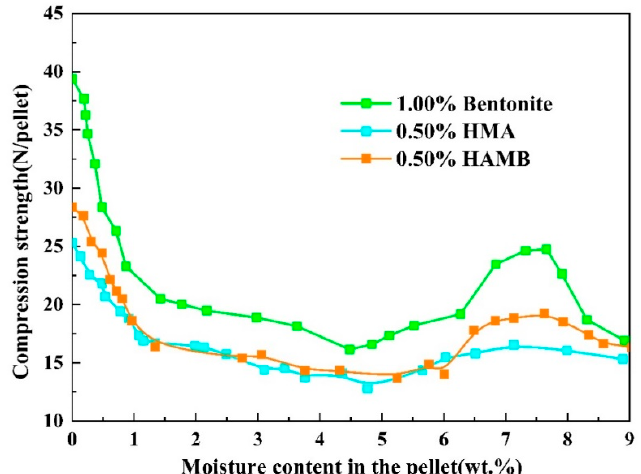
Figure 5. The relationship between moisture content in the pellet and compression strength. After the pelletizing process, the wet strength of the green pellet can reach a certain value due to the capillary force to bond mineral particles together into a mass. Then, at the beginning of the drying process, the capillary water in green pellets began to be elim- inated, and the capillary in green balls began to shrink, which resulted in strengthening the capillary force and the adhesion between particles [1,5,28]. The strength of the green